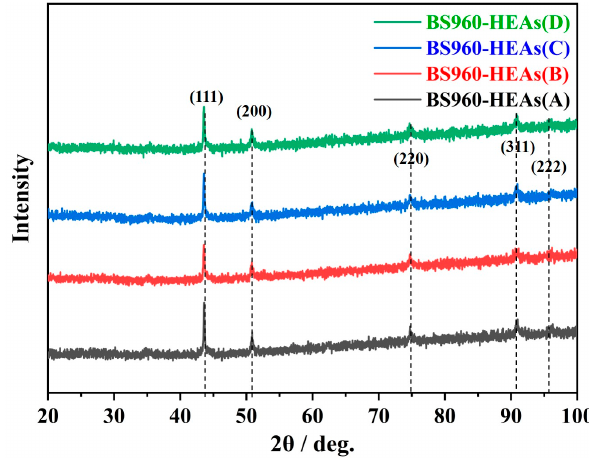
Figure 3. XRD patterns of FeCoNiCrMo 0.2 high entropy alloy coating by plasma spraying at dif- ferent currents.